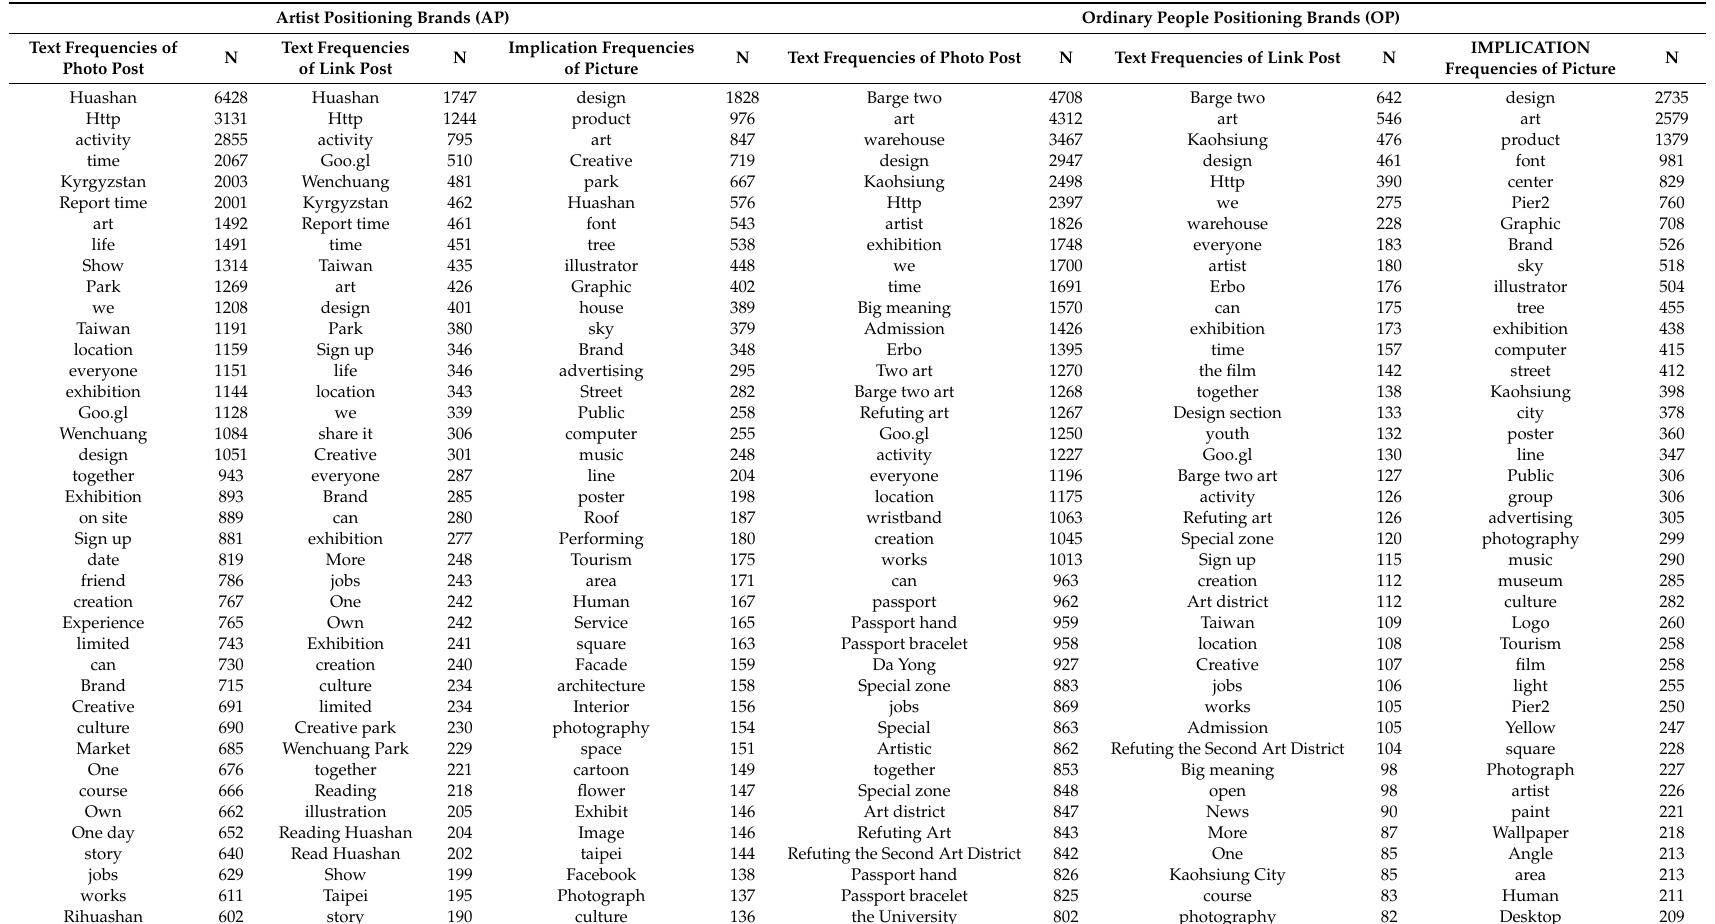
Table A1. Total number of text frequencies and implication